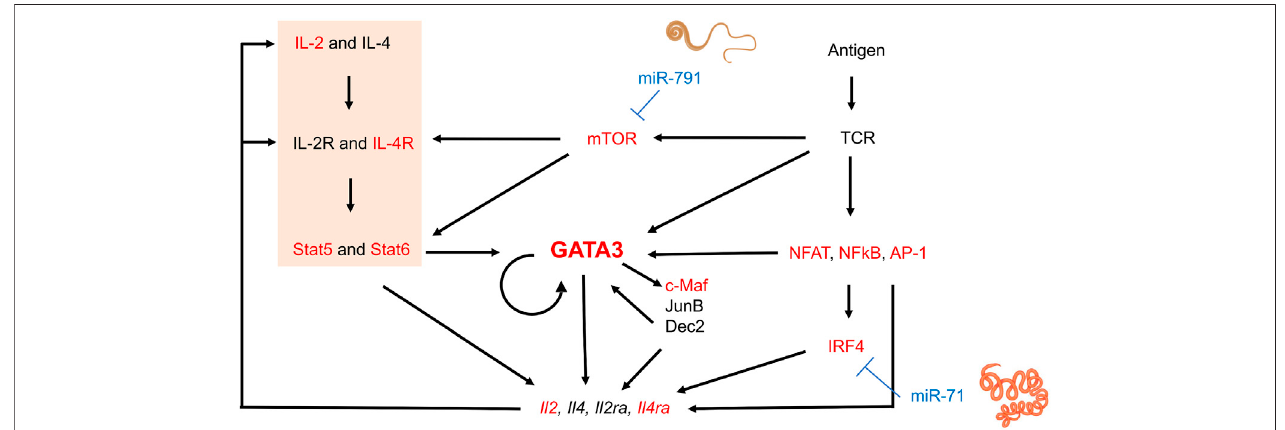
FIGURE 1 | Schematic transcriptional network and positive regulation during Th2 lymphocyte differentiation and interference by nematode miRNAs. Elements in redrepresentgenesofwhichatleastsomeisoformsrepresentpredictedtargetsofthe20mostabundantlysecreted H.polygyrusbakeri,T.muris and A.suum miRNAs. Brie fl y, T cell receptor (TCR) stimulation activates downstream molecules such as nuclear factor of activated T-cells (NFAT), nuclear factor- κ B (NF κ B), and AP-1, in turn leading to upregulation of interferon regulatory factor 4 (IRF4) (Zhu, 2015). IL-4-mediated Stat6 activation and other signaling pathways also induce GATA3 expression.GATA3 may directlyor indirectly regulate Th2 cytokine expression byinducingother transcription factors such asc-Maf, JunB, or Dec2, some ofwhichmay further sustain GATA3 expression. The IL-2 — Stat5 axis is also crucial for Th2 cytokine production and was signi fi cantly downregulated by our transfected miRNAs (orange block). Activated T cells produce IL-2 and IL-4, among others, upregulating IL-2 and IL-4 receptors, creating a positive feedback loop. mTOR in the complex mTORC2 is required for Th2 differentiation via two mechanisms: i) repression of expression of negative regulators of IL4-R and STAT6, and ii) promotion of NF- κ B- mediated transcription (Chi, 2012). Some elements of this image were created with Biorender.com